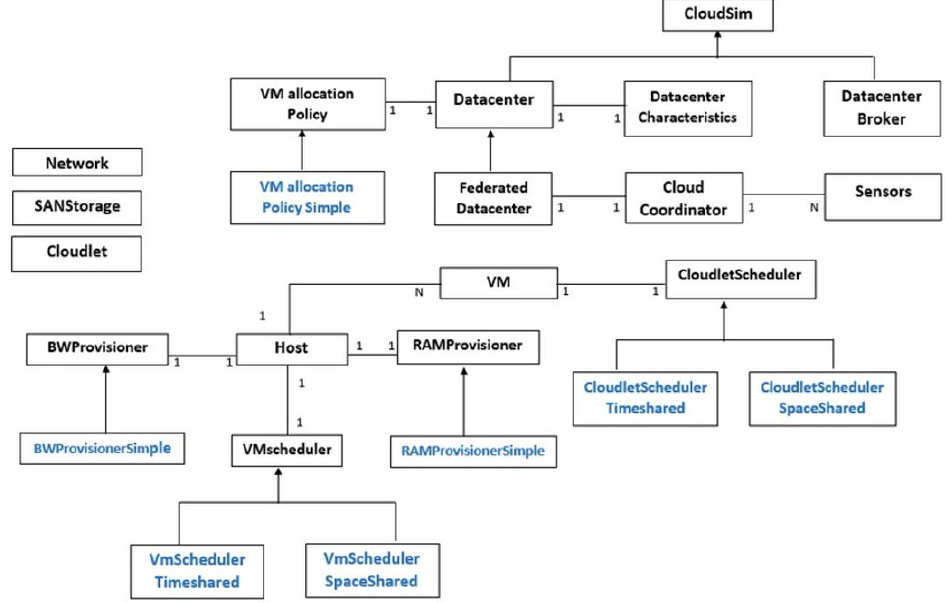
Figure 8. CloudSim architecture (figure was taken from